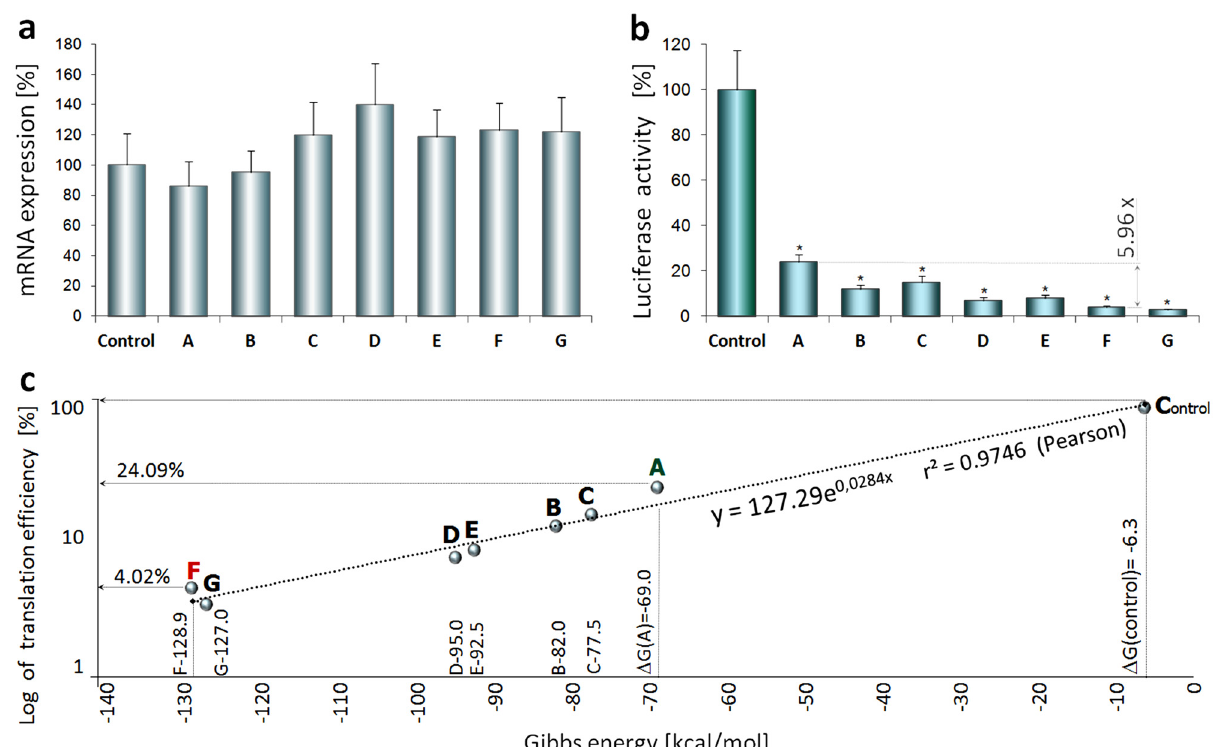
Fig 1. Correlation between Gibbs energy and basic TR β 1 5'UTR-mediated translation efficiency. ( a ) Luciferase mRNA levels from in vitro wheat germ-based coupled transcription-translation assay performed on plasmids containing TR β 1 5 ’ UTR variants A-G are shown relative to control plasmid. ( b ) Effects of 5 ’ UTR variants A-G on luciferase activities after 6h coupled transcription-translation. Three independent experiments were performed in triplicate and shown as mean % mRNA or luciferase activity ± SD. Data were analyzed by ANOVA followed by Dunnett ’ s multiple comparison test; * p < 0.001 vs. control. c , Correlation between the calculated Gibbs energies (X axis) of each 5 ’ UTR variant (S1 Table) and UTR-mediated luciferase translation efficiency. The correlation is shown as the exponential trend-line y = 127.29 * e 0,0248 * X , where x = calculated Gibbs energy; Pearson product-moment correlation coefficient r² = 0,9746. Logarithmically transformed data of translation efficiency (Y axis) were analyzed together with Gibbs energies by linear regression; p = 0.0123.